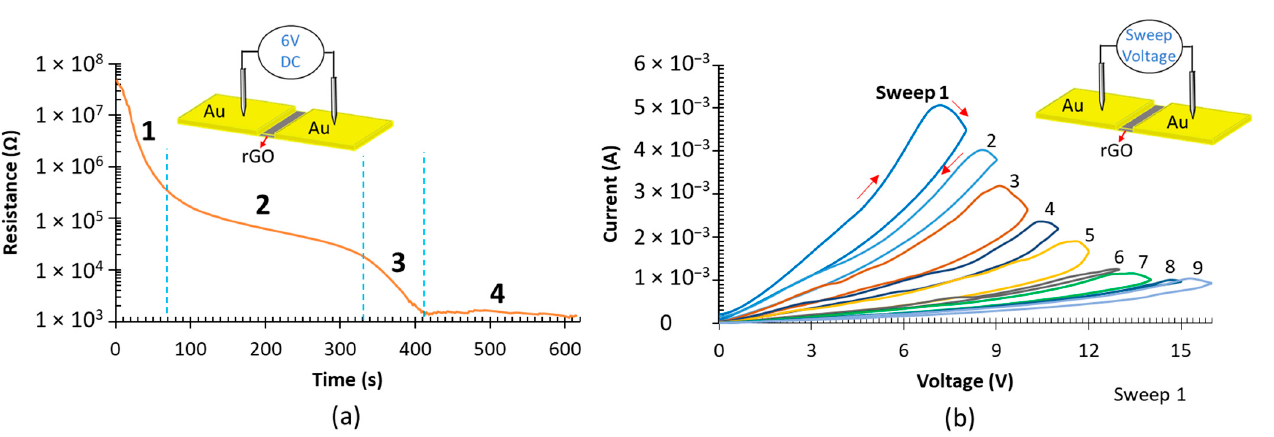
Figure 7. Tunable MR switching behavior. ( a ) Fresh device annealed for 12 h is tested under the application of 6 V DC bias. ( b ) I-V curves for device in ( a ) after the application of the DC voltage bias.